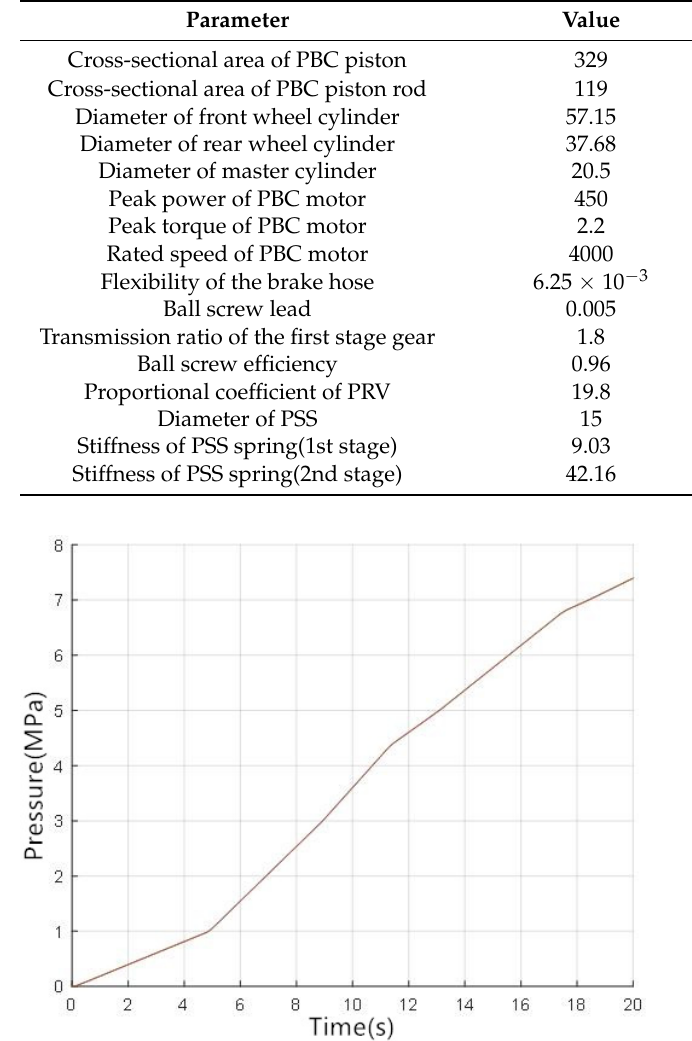
Table 1. Main parameters used in the simulations.